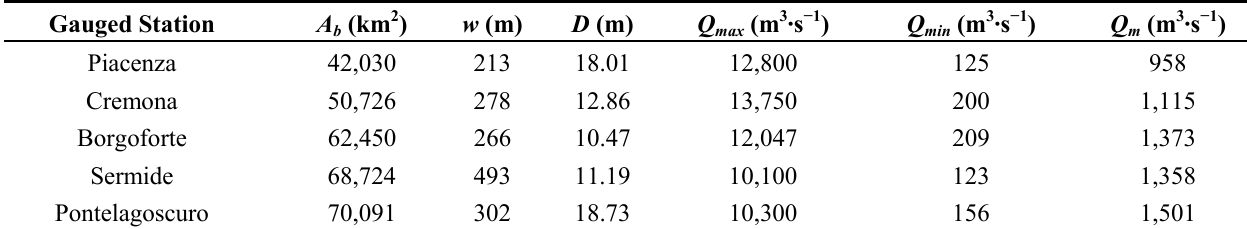
Table 1. Characteristics of the gauged stations of the Po River: basin area ( A ( w ) and river depth ( d ), for bankfull discharge, maximum discharge ( Q ) and mean discharge ( Q discharge ( Q min